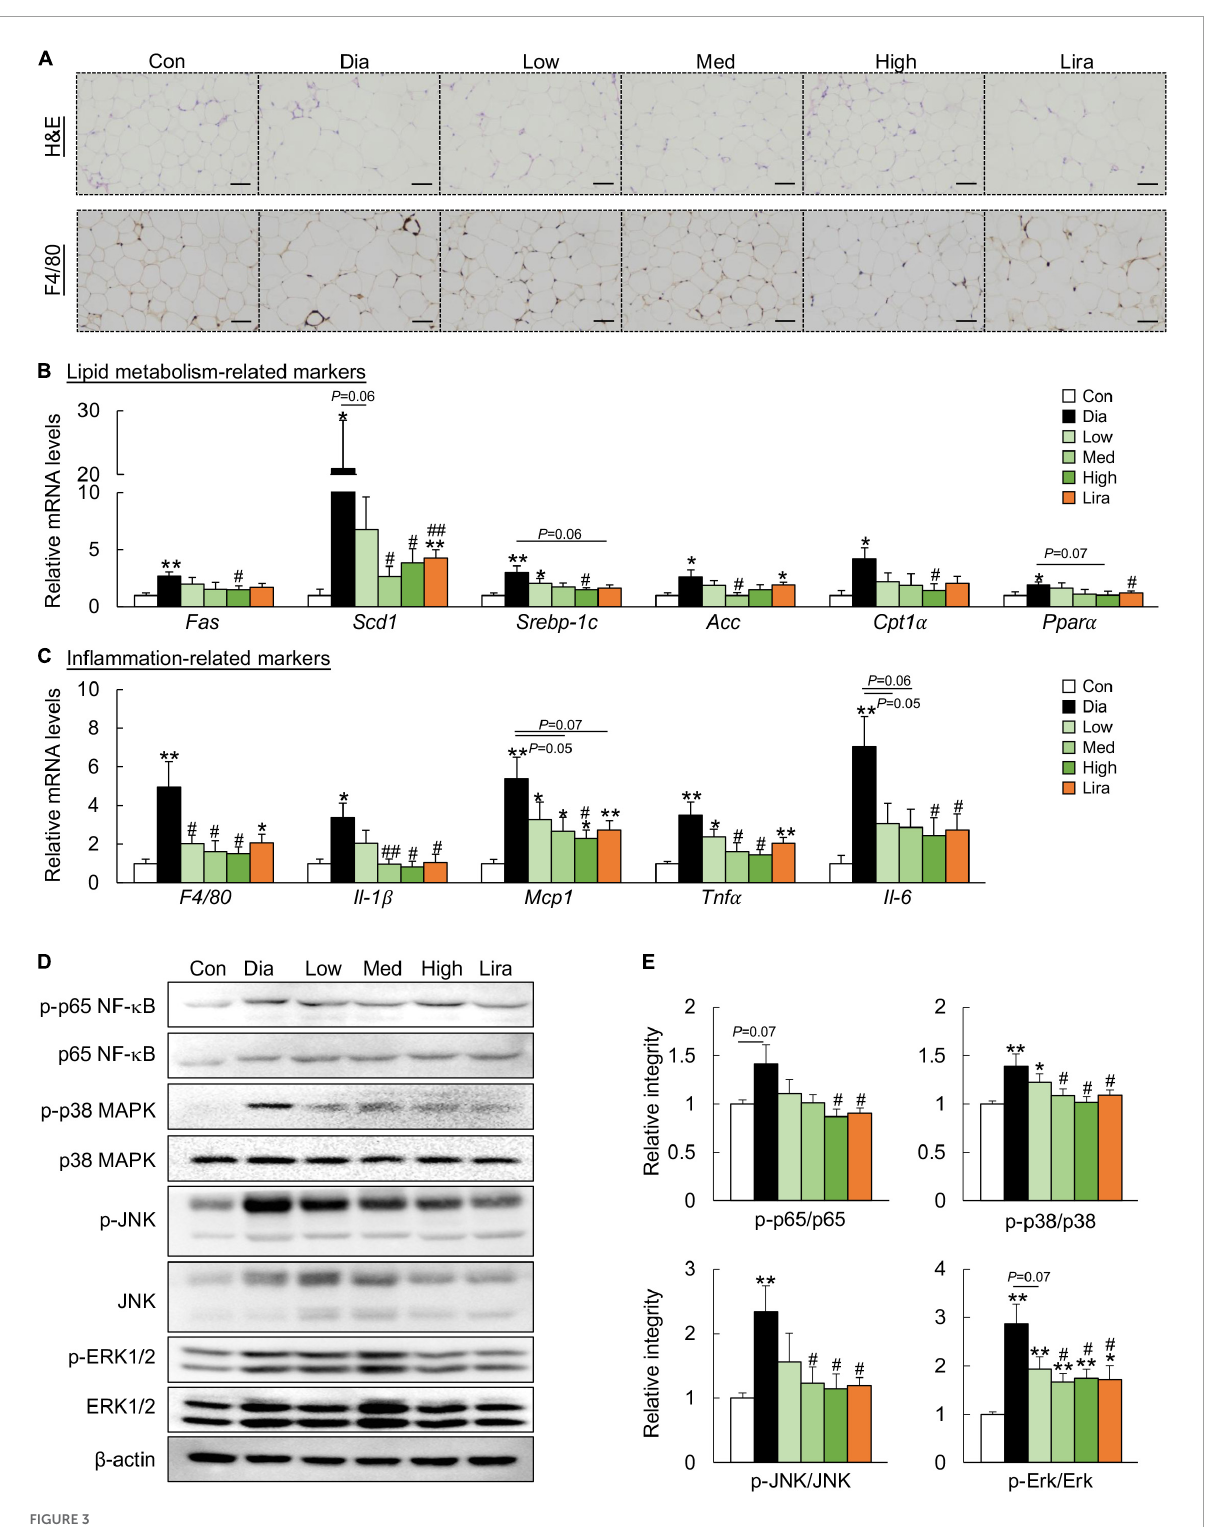
FIGURE3 CFP administration ameliorates metabolic disorders in the eWAT. (A) H&E staining and immunohistochemistry staining for F4/80 in eWAT, Scale bar: 100 µ m. (B) mRNA expression of the adipogenic genes in the eWAT. (C) mRNA expression of the inflammatory cytokines in the eWAT. (D) Immunoblots of p-p65 NF- κ B, p-p38 MAPK, p-JNK, and p-Erk1/2 in the eWAT. (E) Quantification data for p-p65 NF- κ B, p-p38 MAPK, p-JNK, and p-ERK1/2 in the eWAT. Data are presented as the means ± SEM, * P < 0.05, ** P < 0.01 vs. control; # P < 0.05, ## P < 0.01 vs.